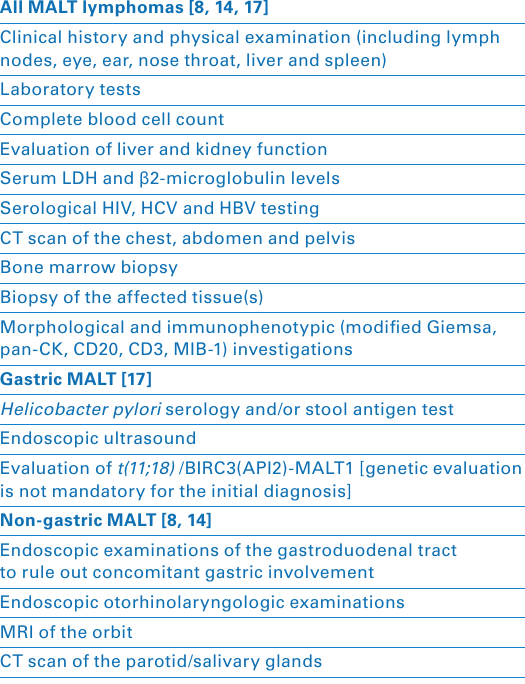
Table 1: Summary of work-up procedures for mucosa- associated lymphoid tissue (MALT) lymphomas. All MALT lymphomas [8, 14,